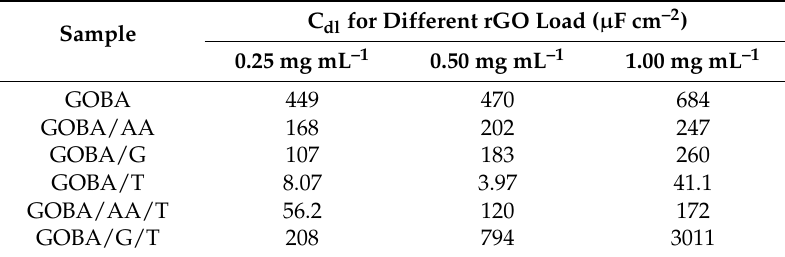
Table 3. Double layer capacitance dependence on rGO load.